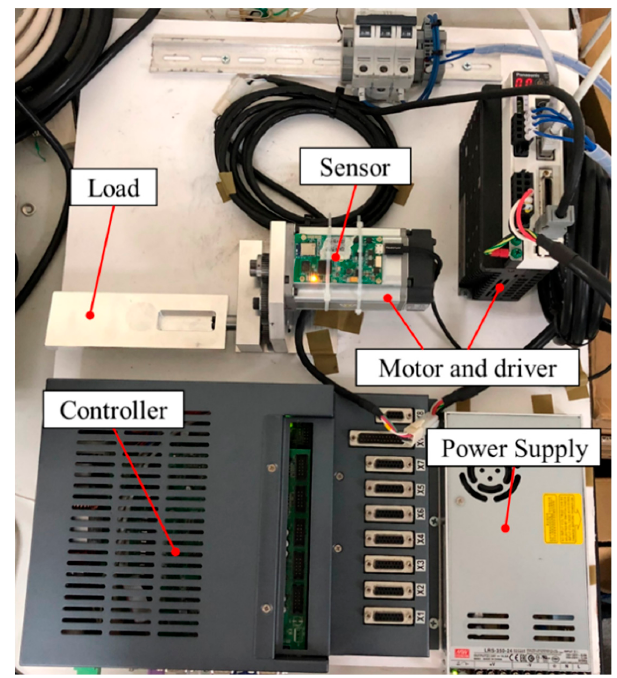
Figure 11. The platform of gear mechanism in National Chung Hsing University (NCHU).